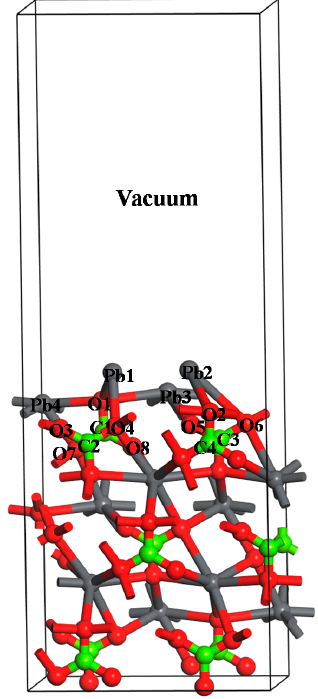
Figure 1. Slab model of perfect cerussite (110) surface.